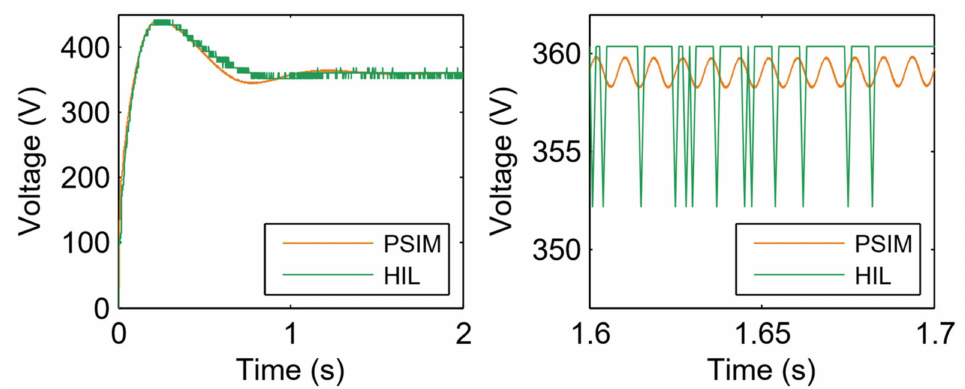
Figure 28. v dc response under closed loop and inverter mode conditions.